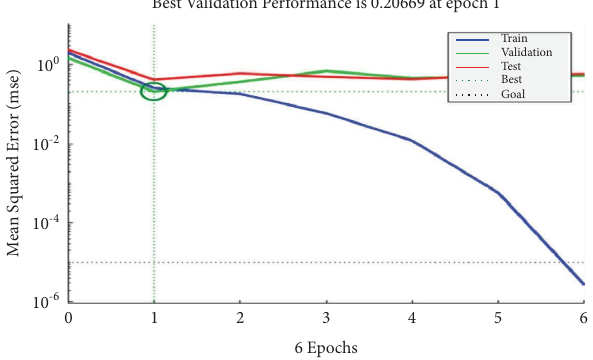
Figure 7: Network performance.